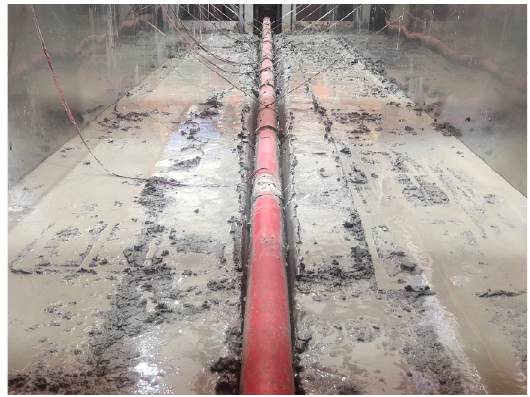
Figure 35. Developed trench